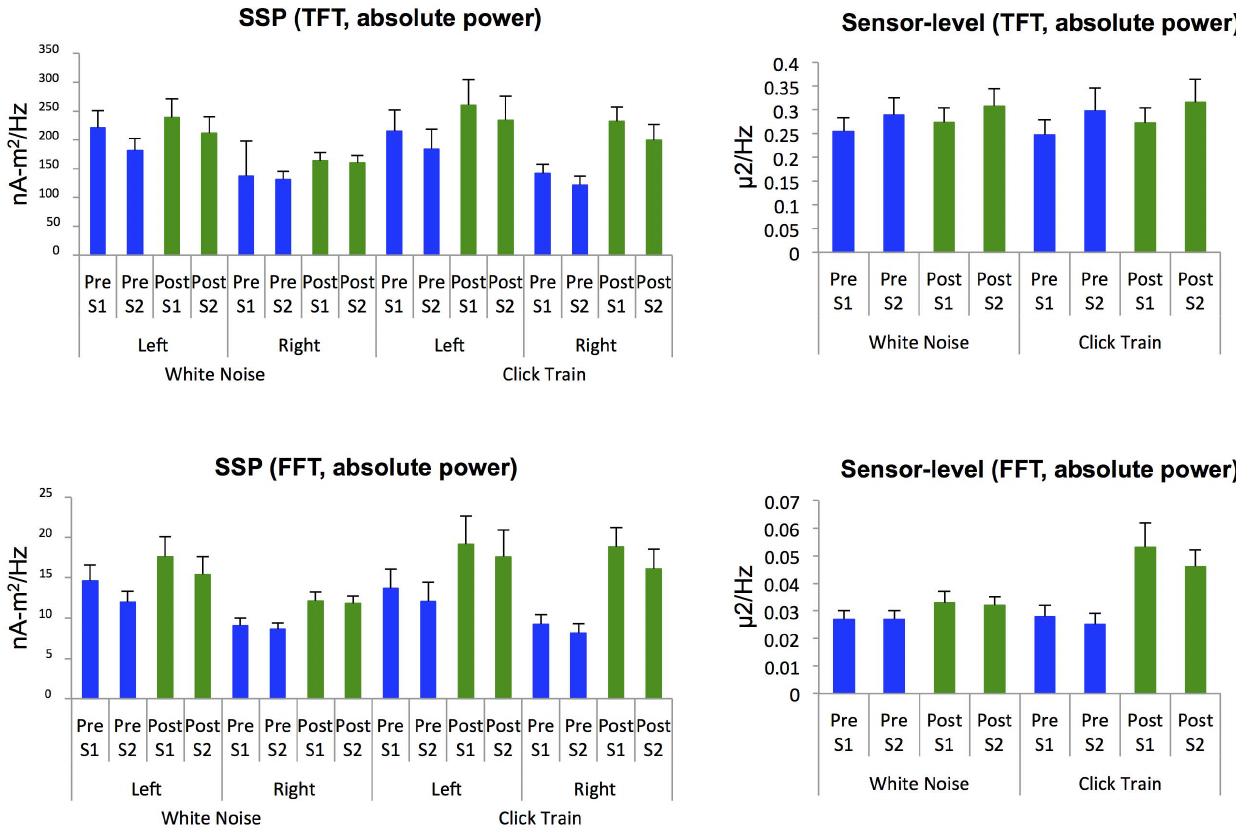
Figure 2. Average absolute power at 40 Hz. Absolute power for both the pre-stimulus window (Pre; 2 200–0 ms for TFT, 2 300–0 ms for FFT) and post-stimulus window (Post; 200–500 ms), for both session 1 (S1) and session 2 (S2) for both the white noise and click train stimuli. Results are shown for signal-space projected (SSP) and sensor-level (at FCz) data. TFT: time-frequency transformed data; FFT= Fast Fourier transformed data.